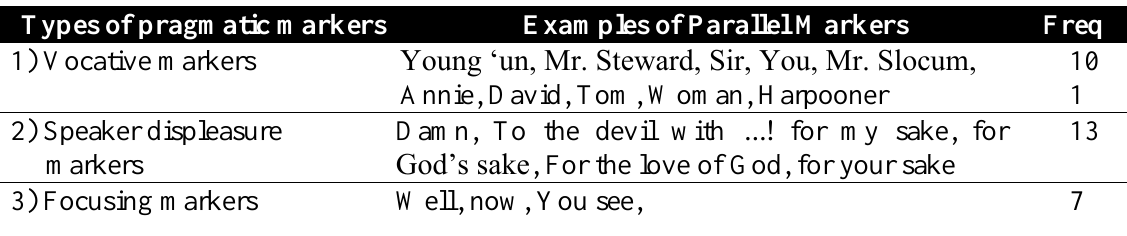
Table 3: Frequency Scale of Parallel Markers in